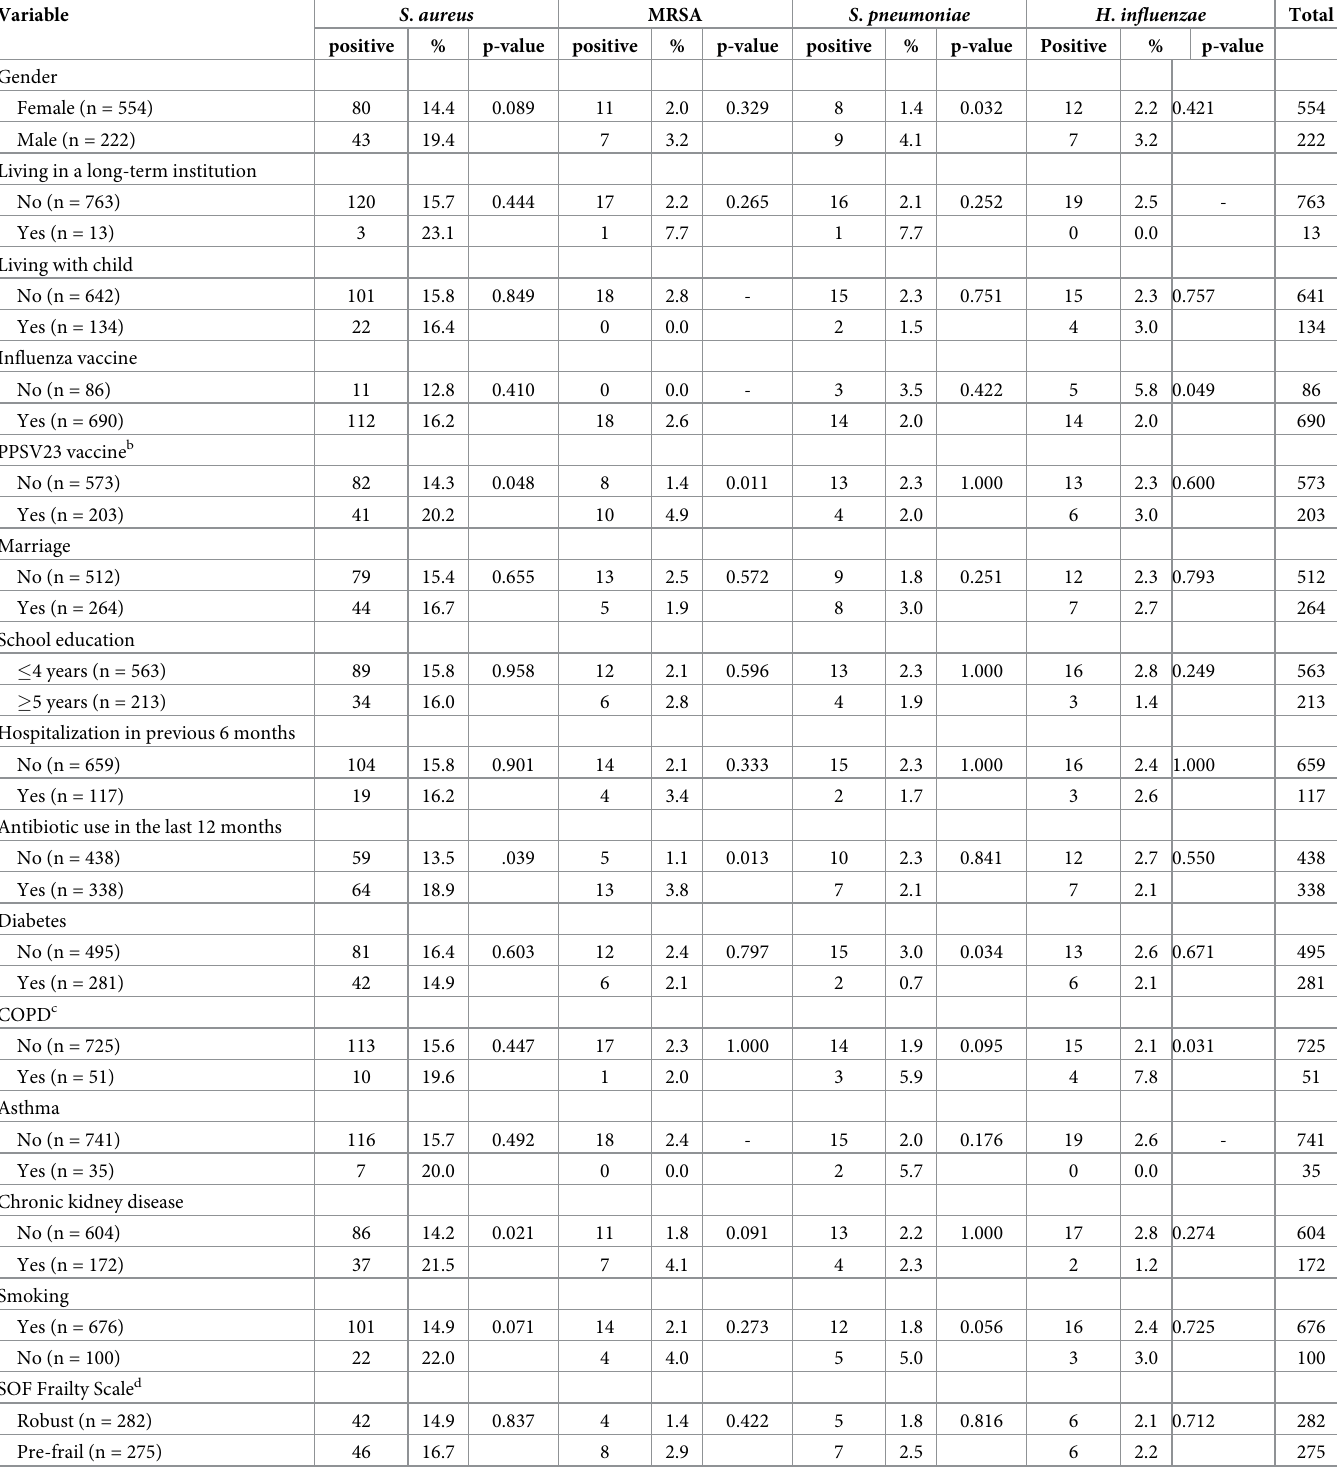
Table 3. Demographic characteristics, medical conditions, and risk factors for carriage of Staphylococcus aureus , methicillin-resistant Staphylococcus aureus (MRSA), Streptococcus pneumoniae , and Haemophilus influenzae in visit 1 among elderly participants a (N = 776).